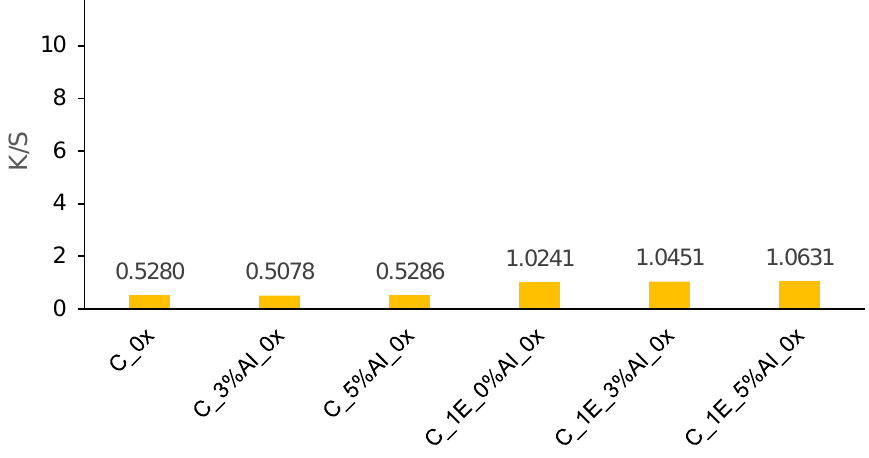
Figure 6. K/S values of cotton samples which are untreated (C_0x), treated only with mordants (C_3%Al_0x and C_5%Al_0x) or dyed with (C_1E_3%Al_0x and C_1E_5%Al_0x) and without mordants (C_1E_0%Al_0x).